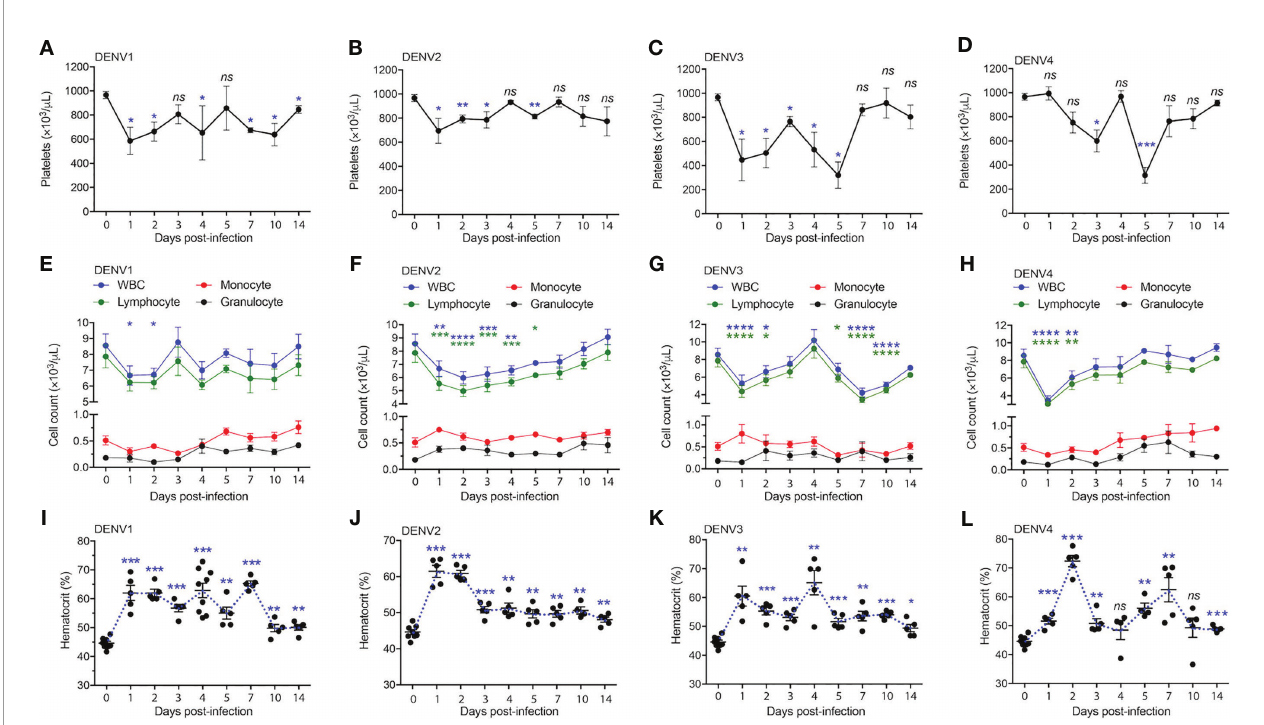
FIGURE 4 | Full blood count shows thrombocytopenia, leukopenia and increase in the hematocrit of mice infected with serotypes, DENV1-4. Blood from mice (n=5- 10) infected with DENV1-4 was collected at various days post-infection and subjected to complete blood count measurements. (A – D) , shows signi fi cant drop in the platelet counts starting from days 1-5 for each of the DENV serotypes. (E – H) , shows reduction in the number of lymphocytes and WBCs ranging from days 1-4 post-infection for each of the DENV serotypes tested. (I – L) , increase in the hematocrit (volume of packed red blood cells in the blood) for mice infected with DENV1-4. Hematocrit was signi fi cantly higher post-DENV infection for all the time points collected, however trending to be close to baseline levels by day 14. Signi fi cance was determined by comparison to baseline values (day 0) by 1-way ANOVA and is shown by * for p<0.05, ** for p<0.01, *** for p<0.001 and **** for p<0.0001, ns, not signi fi cant, compared to the baseline. Baseline values are shown as day